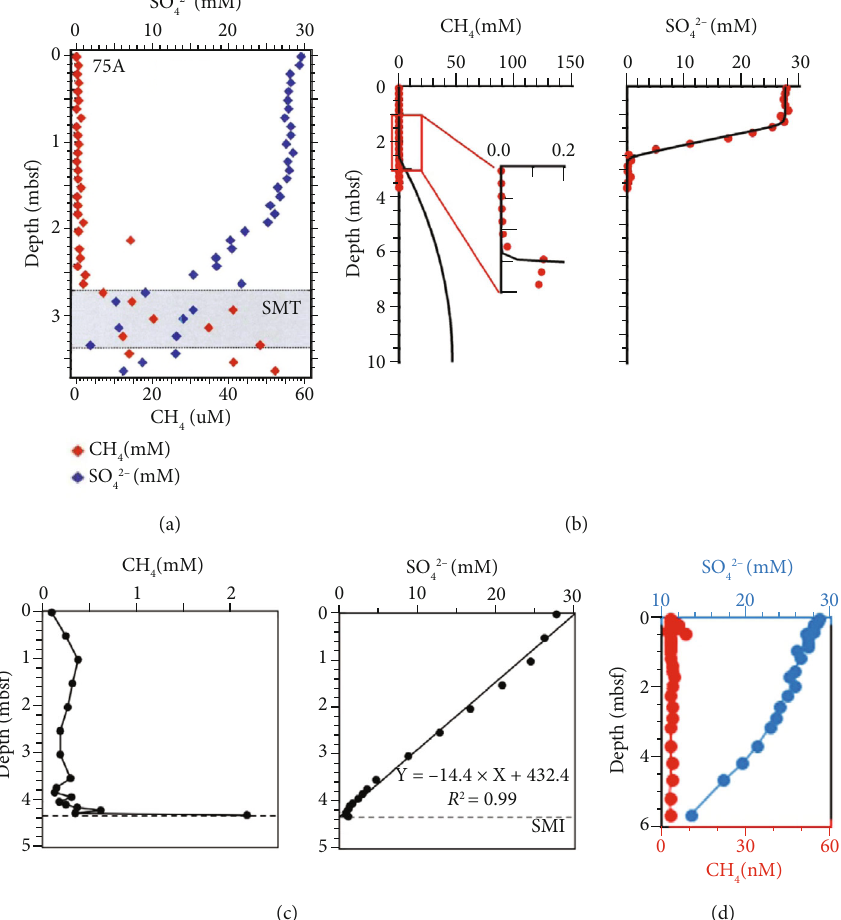
Figure 6: The depth pro fi les of the concentrations of CH and SO 42- of the pore waters. They show relatively shallow SMTZ depths. (a) 4 Core-75A (from [21]). (b) CG08 (from [28]). (c) ESC-15-08 (from [26]). (d) C25 (from [23]). Their locations can be found in Figure